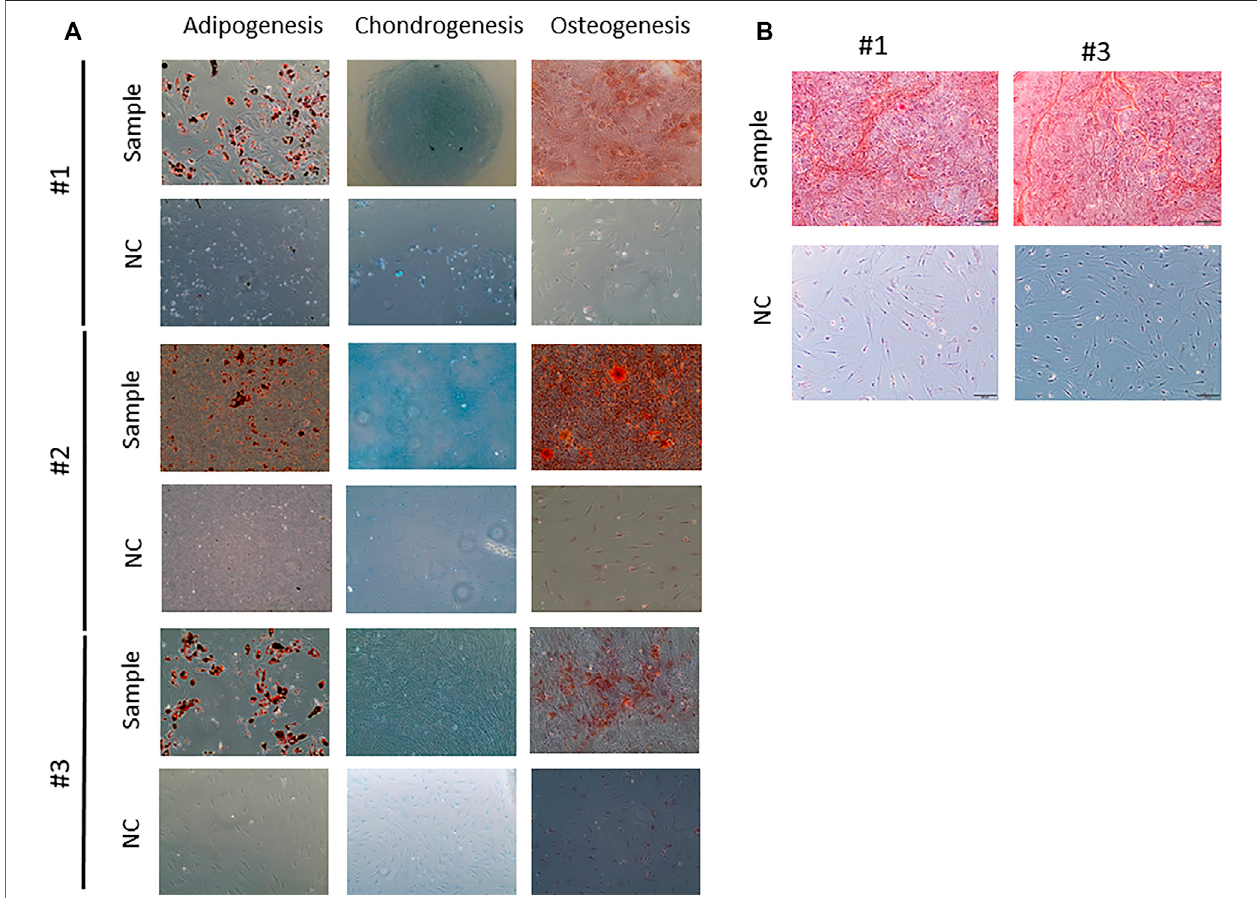
FIGURE 4 | Multilineage Mesenchymal stem cell differentiation. (A) Adipogenesis differentiation. In negative control group (without adipogenic differentiation), no lipid droplets were observed. Lipid droplets are given in red. Chondrogenesis differentiation. In the control, no blue reaction was observed there is a slightly positivity showing the presence of proteoglicans. Osteogenesis differentiation. In the negative groups, no calcium deposits were observed. The healthy donor cells showed a strongpresenceofcalciumdeposits,andthepatientcellsexhibitedaweakstaining.20-foldmagni fi cation. (B) Imagesofosteogenicdifferentiationfrompatients#1 and